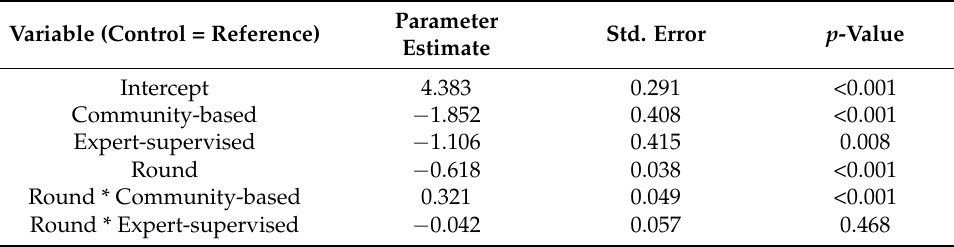
Figure 5. Number of houses with adult An. gambiae per survey round in the control arm (panel ( A )) and number of adult An. gambiae per house per survey round in the control arm (panel ( D )). Similarly, in panels ( B , C , E , F ), the same outcome parameters are shown for the CB arm and ES arm, respectively. Table 3. Parameter estimates for the GLMM of adult An. gambiae per house with house included as random